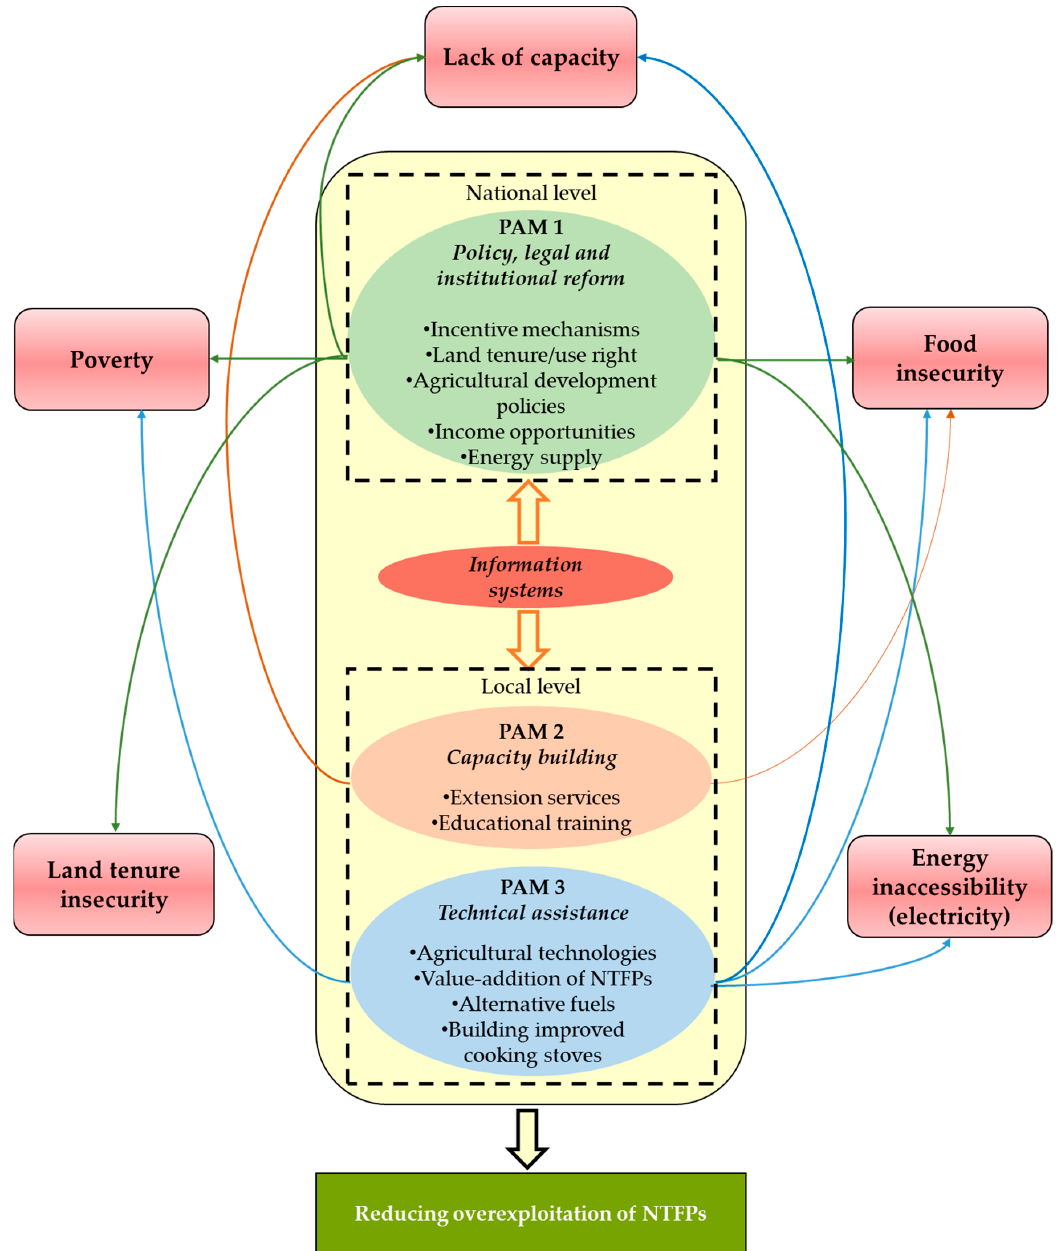
Figure 4. Illustration of potential combined package of policies and measures to solve main problems of NTFPs overexploitation. PAM: policies and measures, Source: Adapted from [15,16].